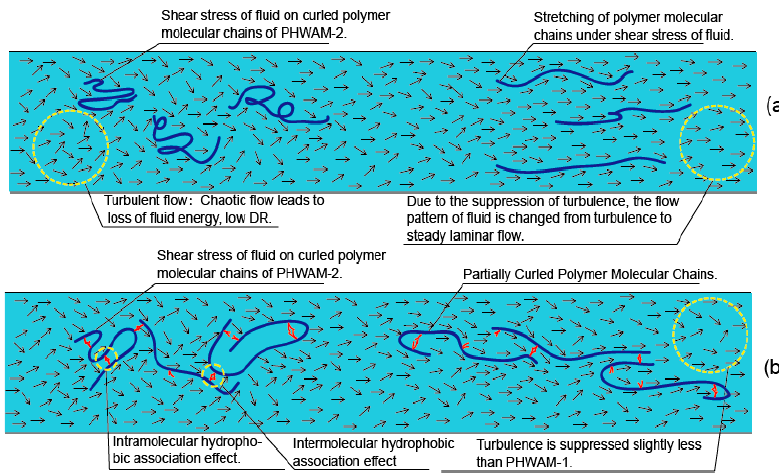
Figure 5. DR mechanism of polymer drag reducers ( a ) without a hydrophobic monomer and ( b ) with a hydrophobic monomer in fresh water.